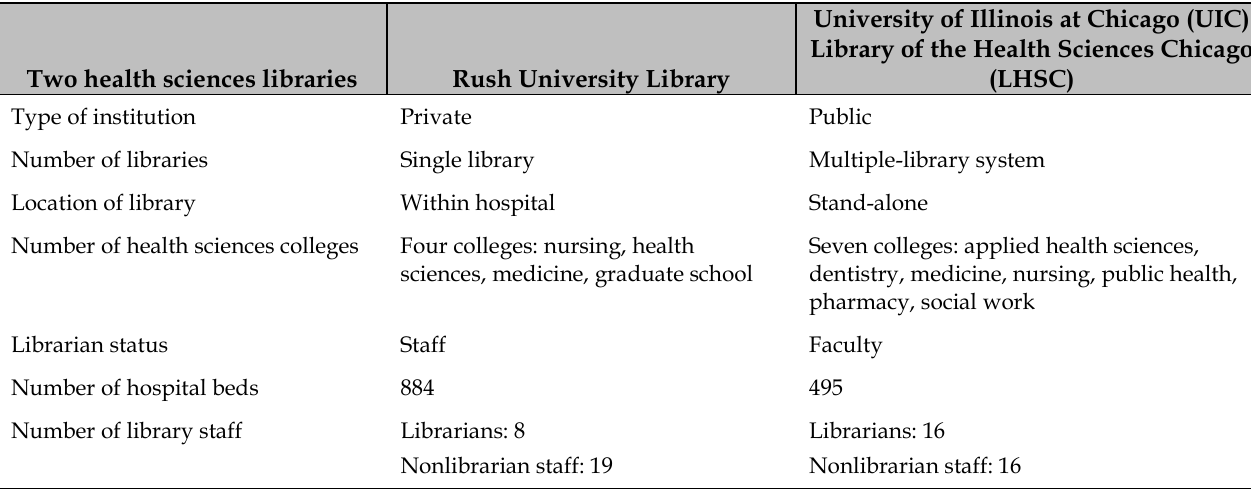
Table 1 Practicum site